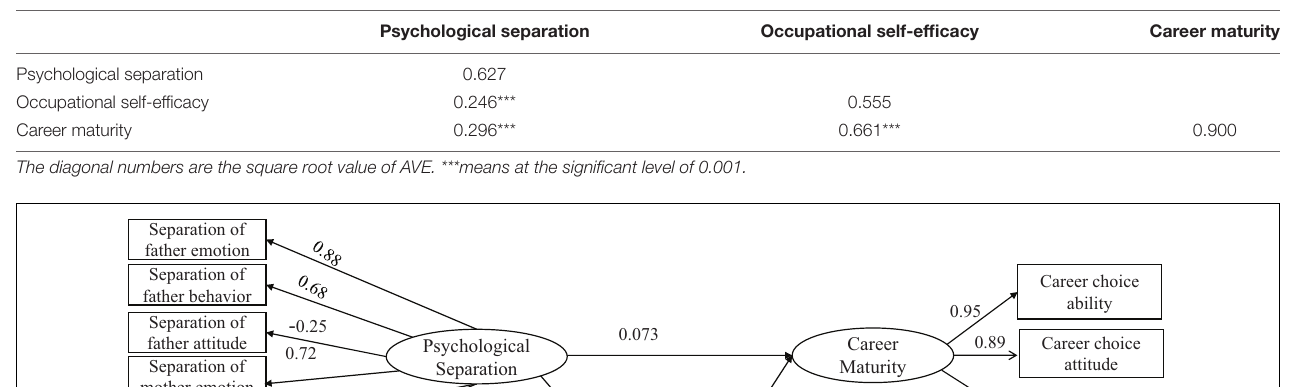
TABLE 3 | Pearson correlation and AVE square root value.